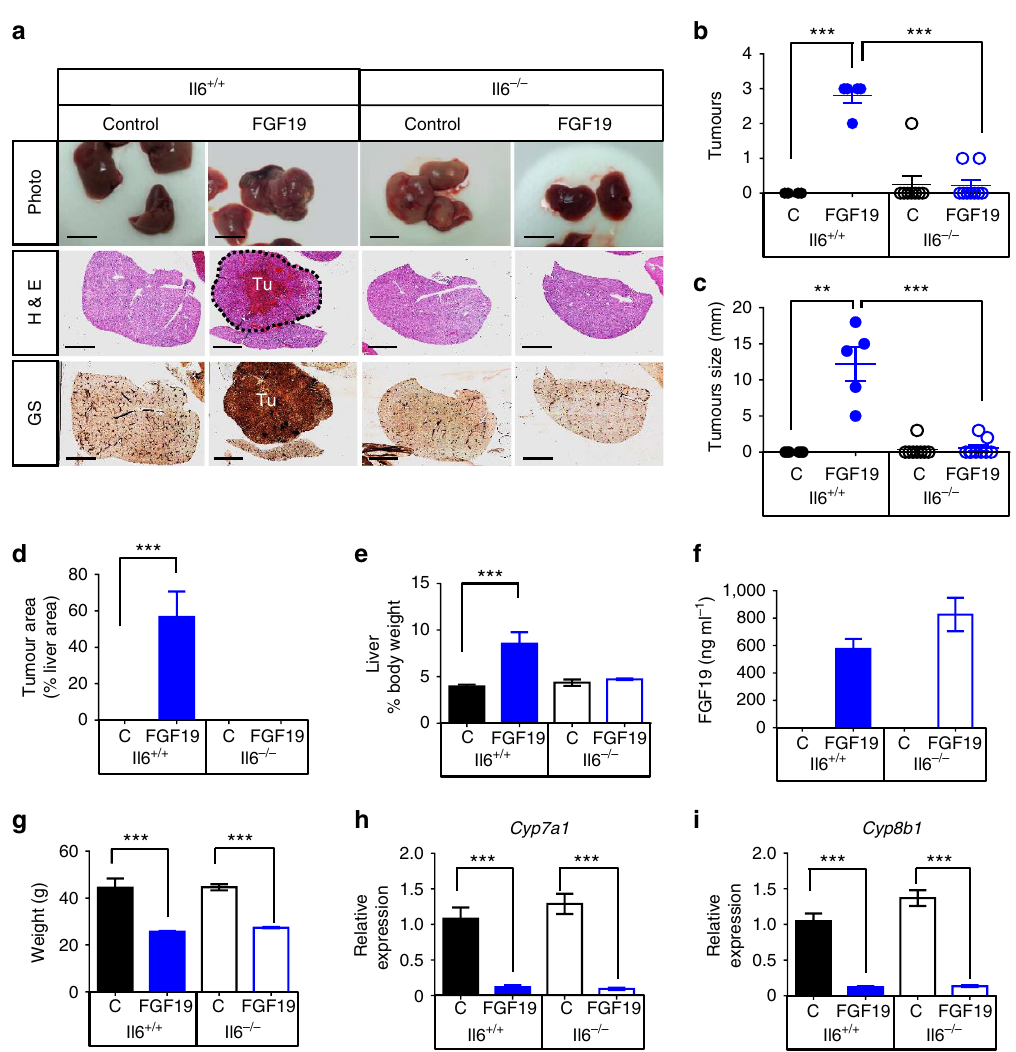
Figure 6 | Homozygous deletion of IL-6 prevents FGF19-induced HCC development. Il6 þ / þ or Il6 (cid:3) / (cid:3) mice received a single tail vein injection of AAV- FGF19 or a control virus (C). Mice were killed after prolonged exposure to FGF19 for 12 months. ( a ) Representative images of livers from mice of the indicated genotypes are displayed. Liver tumours were assessed by H&E (middle panels) and anti-glutamine synthetase (GS, bottom panels, positive signal shown as brown colour) staining. Tu, tumours. Scale bars, 5mm. Animal groups are Il6 þ / þ control ( n ¼ 5), Il6 þ / þ FGF19 ( n ¼ 5), Il6 (cid:3) / (cid:3) control ( n ¼ 8), Il6 (cid:3) / (cid:3) FGF19 ( n ¼ 9). ( b ) Numbers of macroscopic tumours per liver. Dots in scatterplot represent individual animals. ( c ) Tumour size. ( d ) Quantification of tumour area. ( e ) Ratios of liver-to-body weight. ( f ) Circulating FGF19 levels at the end of the study. ( g ) Body weight of the animals. ( h ) Quantitative RT-PCR of hepatic Cyp7a1 expression. ( i ) Hepatic Cyp8b1 mRNA levels. Values are mean ± s.e.m. *** P o 0.001, ** P o 0.01 versus control group by unpaired, two-tailed t